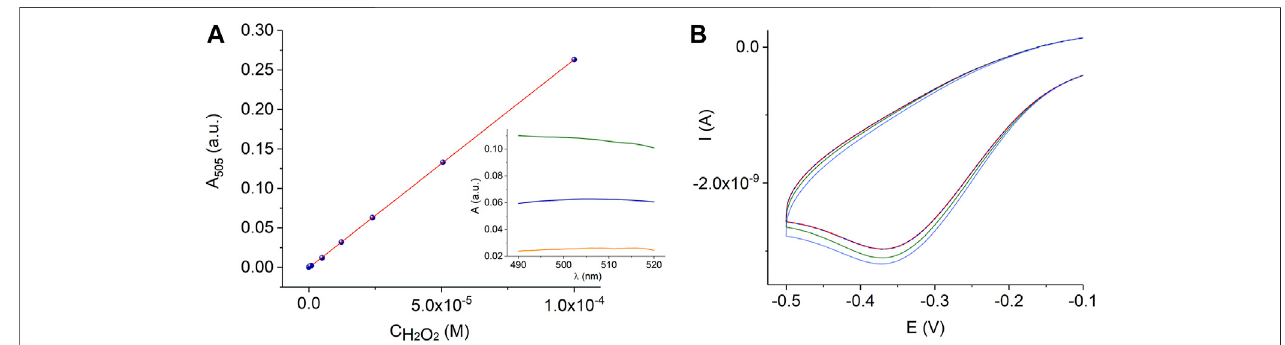
FIGURE8| Calibration graphfor the peroxidase-coupled reaction accordingto reaction scheme(1)in 0.06 M PB, pH 7.4, R 2 (cid:2) 0.9998, where R 2 isthe coef fi cient of determination ofthe linearregression. The insert shows the absorbance spectra ofaquinoneimine product ofthe colorimetric reaction of2.4 · 10 – 5 MH 2 O 2 inPB (blue line) and plant leaf extracts (sun fl ower, Helianthus annuus L. , - orange line and Kalanchoe blossfeldiana - green line) (A) . Electrochemical measurements with the AuND/ ErGO/MnTMPyP electrochemical system in the wheat plant extracts (dashed red line) with additions of hydrogen peroxide (green and blue lines) (B) .